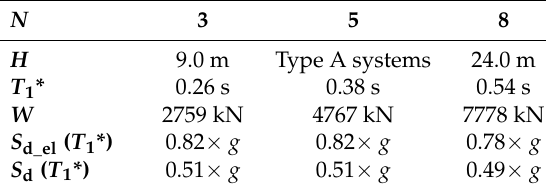
Table 1. Initial design characteristics of case study seismic force resisting systems (SFRS).